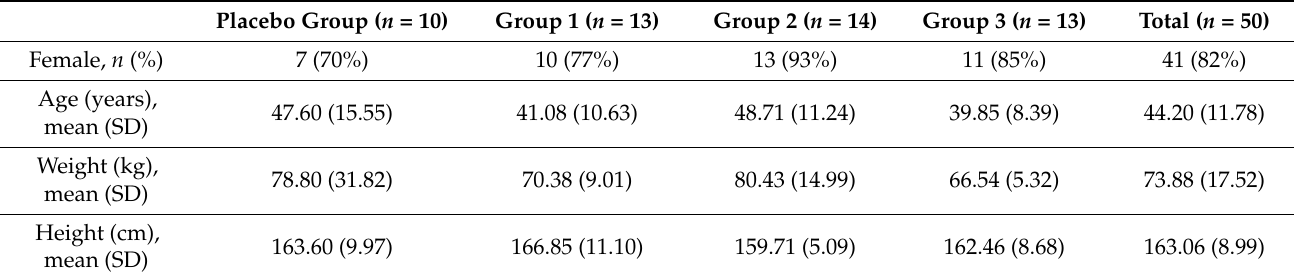
Table 1. The baseline characteristics of the study population.